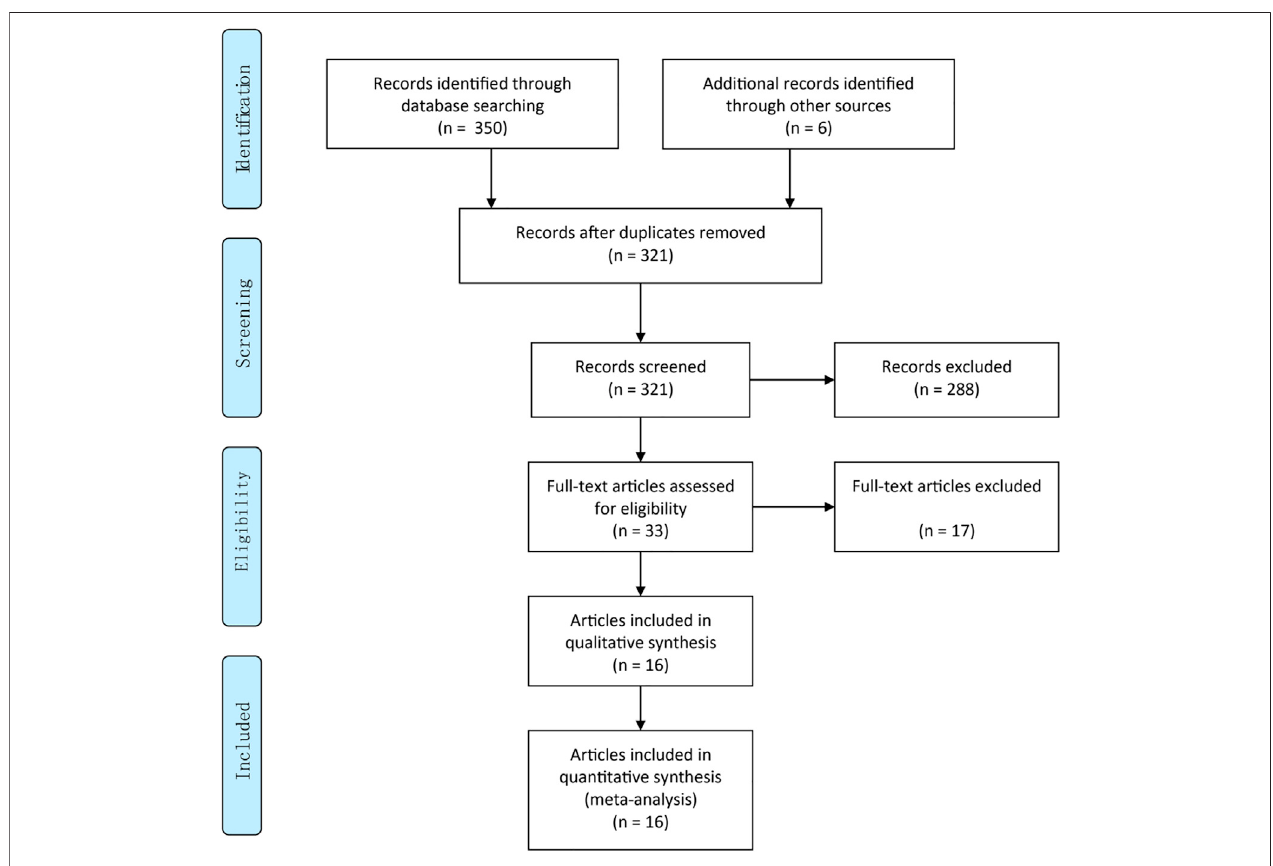
FIGURE 1 | PRISMA 2009 fl ow diagram.